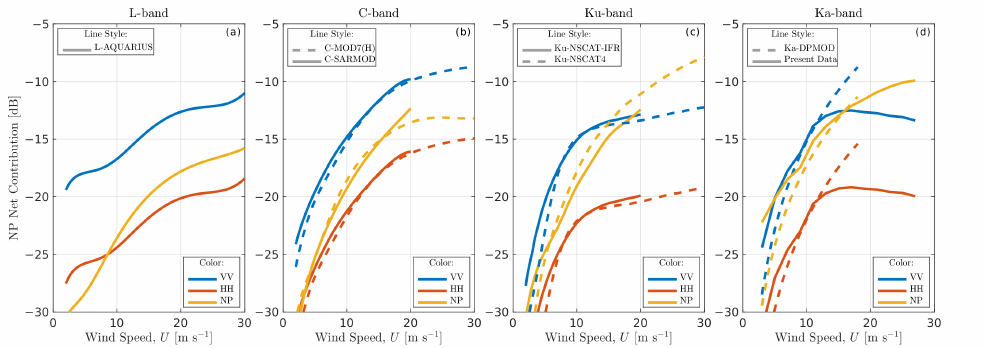
Figure 7. NRCS contribution of co-polarized (VV, HH) and non-polarized (NP) components versus wind speed.